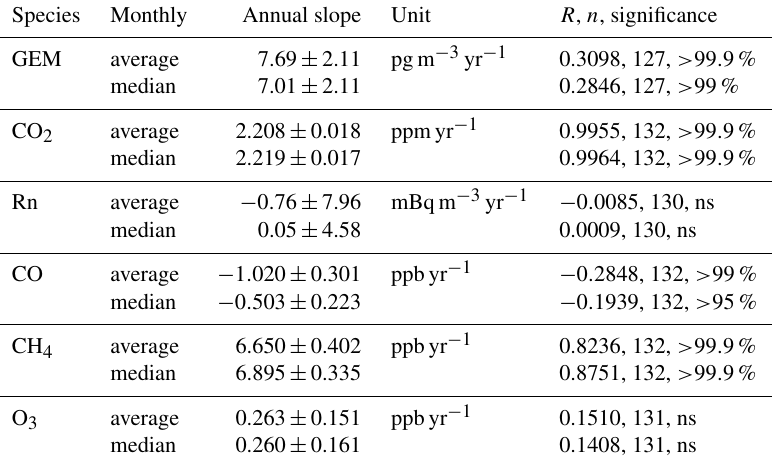
Table 1. Trends at Cape Point for the 2007–2017 period. Calculated by least-squares fitting (LSQF) from monthly averages and medians.